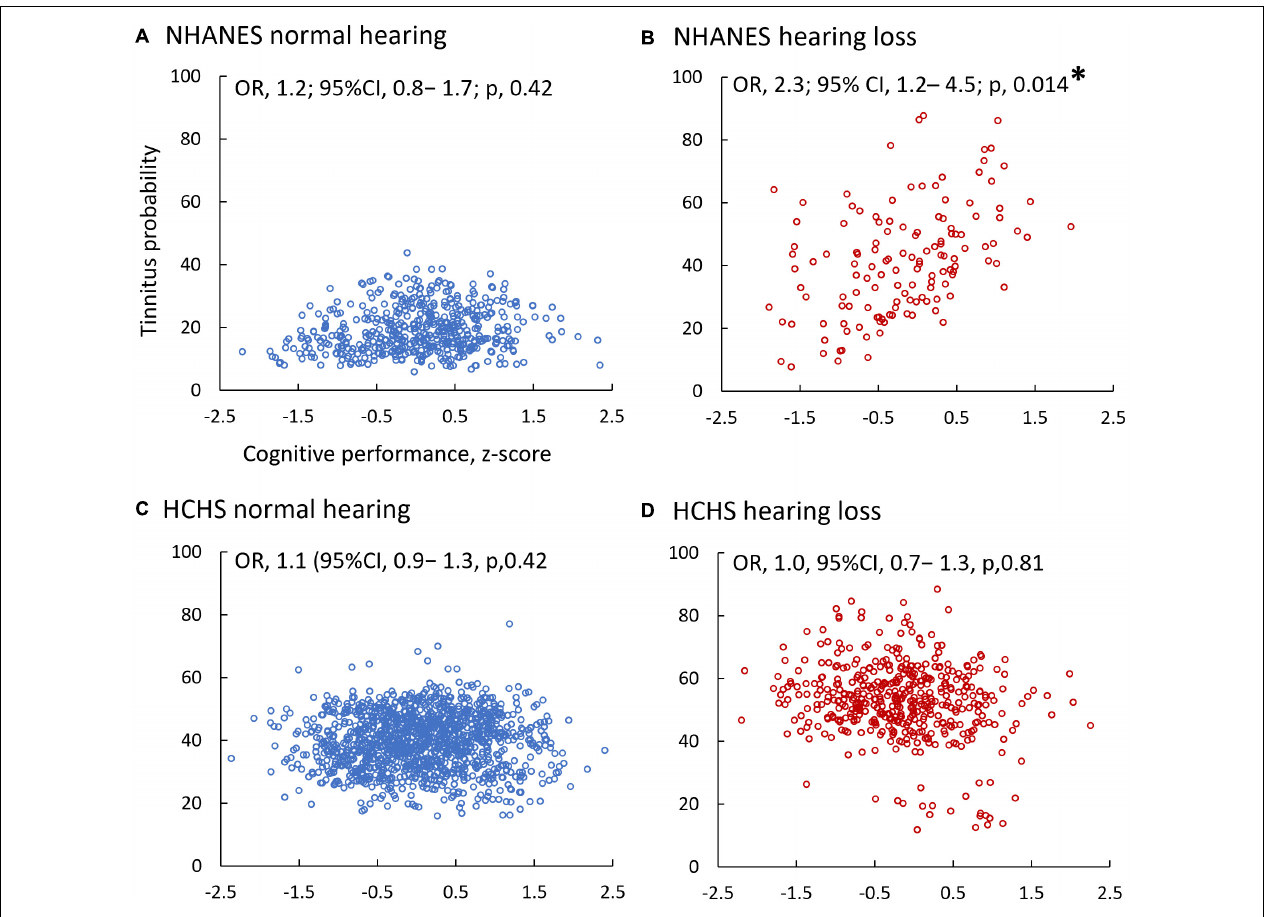
FIGURE 4 | Adjusted Tinnitus Probability as a Function of Cognitive Performance in the NHANES (A,B) and HCHS (C,D) Sub-Cohorts. Multivariable binary logistic regression models predicted the adjusted probability. Blue circles denote normal hearing (A,C) , and red circles are of hearing loss (B,D) . ∗ indicates a significant association between tinnitus and cognition ( p <